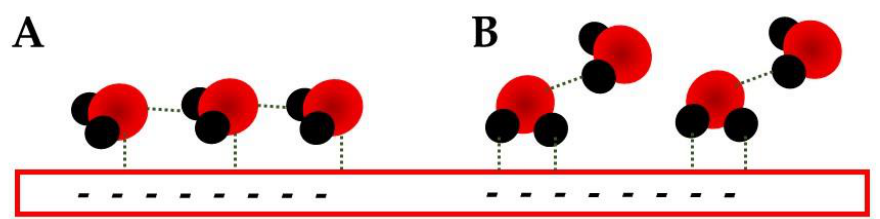
Figure 6. Representation of the two H-down conformation described by Li et al. [11] at potentials more negative than PZC; ( A ) is expected for shortly more negative than the PZC and ( B ) for potentials much more negative.